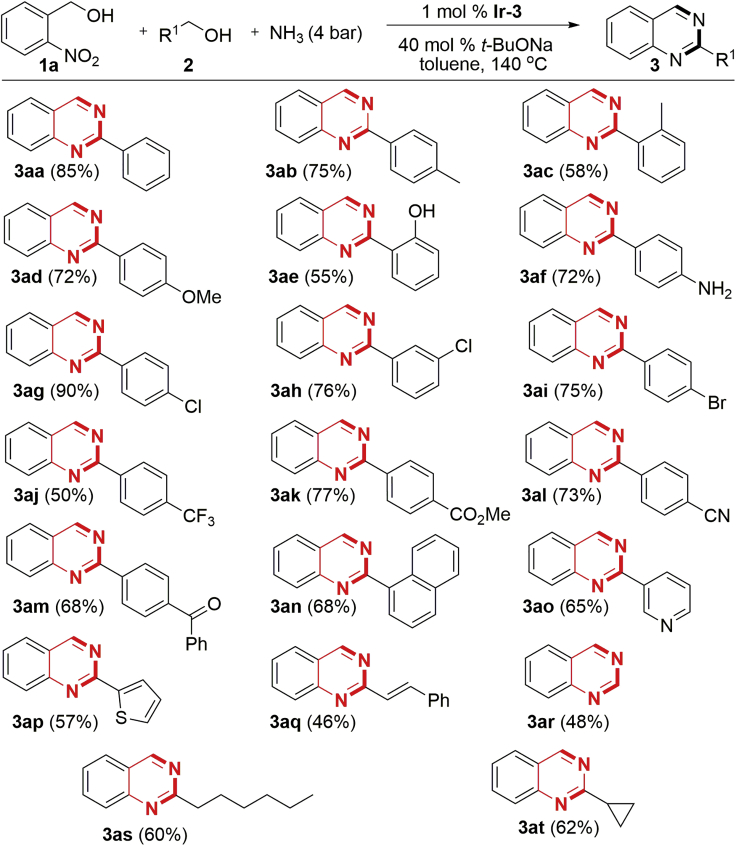
Variation of AlcoholsAlso see Scheme S1, Figures S1−S60 and Data S3.